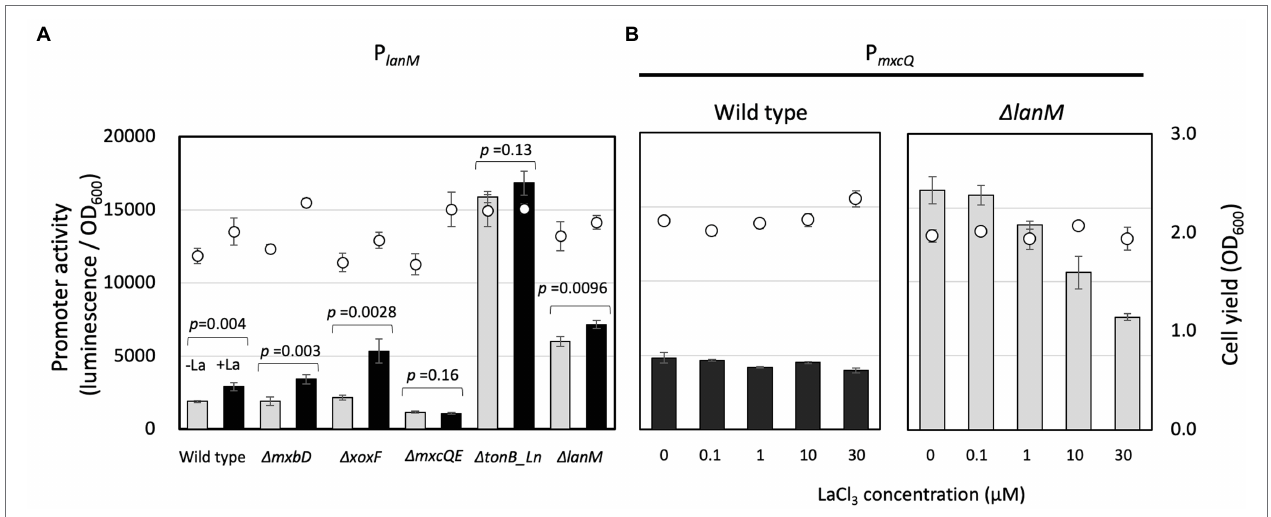
FIGURE 5 | (A) P lanM activity in the mutants grown on methanol plus succinate. Promoter activity was assessed as maximum luminescence per OD600 of the culture at the time. Gray bars, without LaCl 3 ; filled bars, with 30 μ M LaCl 3 ; circles, cell yield (OD600). The promoter activity was analyzed by Student’s t -test and p values are indicated. (B) P mxcQ activity in the wild type and Δ lanM grown on methanol in the presence of varied concentrations of LaCl 3 . Bars, P mxcQ activity; and circles, cell yield (OD600). Data are presented as the mean value ± standard deviation (SD; n = 3).